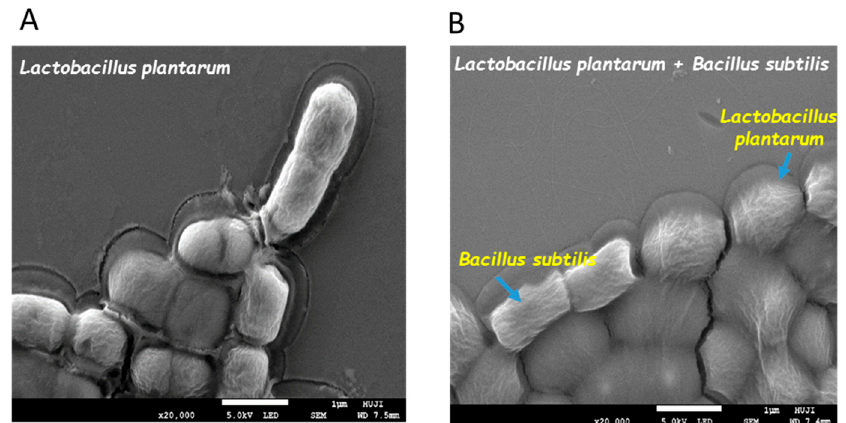
Figure 4. Bio-coating of L. plantarum cells by extracellular polymeric substance(s) produced by B. subtilis . Mono and dual-species cultures of B. subtilis and L. plantarum cells were generated in MMRS medium during bacterial growth for 8 h in 37 ◦ C, 50 rpm. ( A ) SEM images of the mono-species culture of L. plantarum and ( B ) dual-species culture of L. plantarum with B. subtilis following desiccation conditions (40% RH) for 20 h. Images were taken at a magnification of 20,000 × with a JEOL, JSM 7800F, Japan.